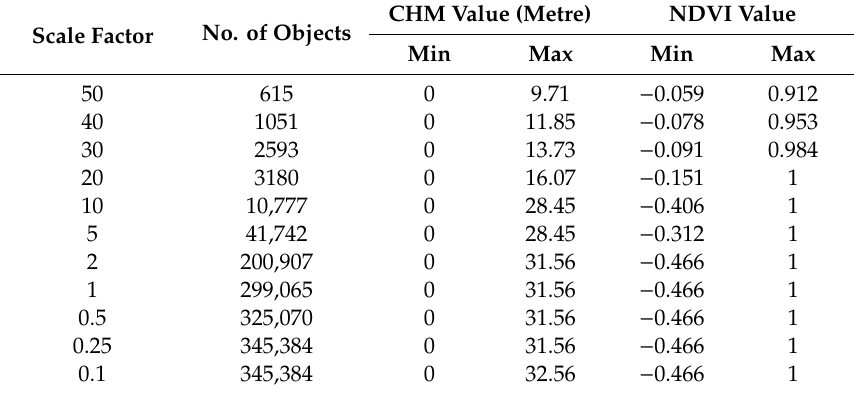
Figure 7. Flowchart showing a convolutional neural network (CNN) and classification refinement workflow in eCognition software.